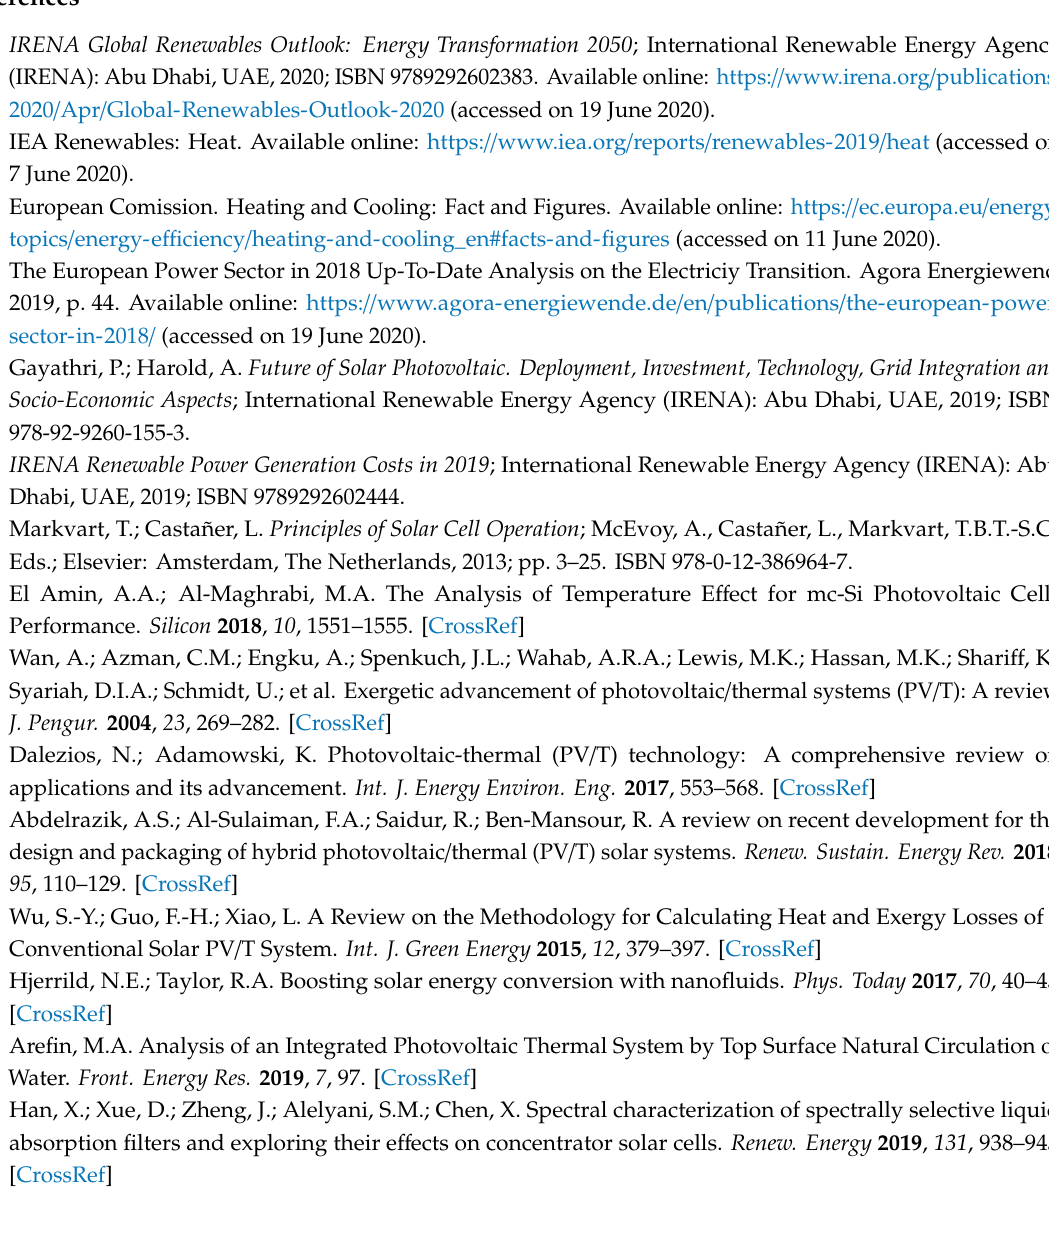
PLDS nanofluid filters, Figure S3: The variation in the internal structure (particle size-distribution) of the di ff erent types of the PLDS nanofluid in response to the increased concentration of the silver nanoparticles, Figure S4: The instantaneous change in the surface temperature of the C-PV mc-Si cell ( ∆ T PV Cell ) under the di ff erent filtered spectral irradiances provided by the PLDS